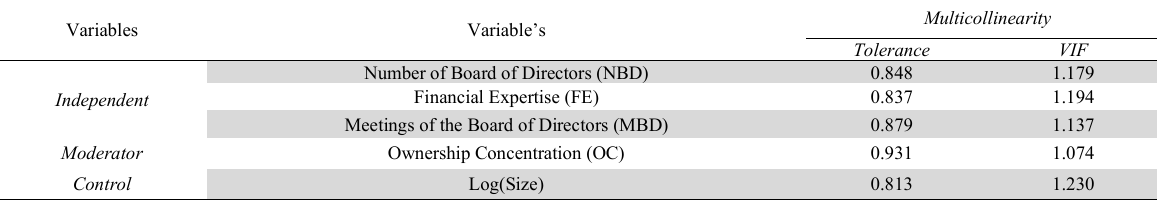
The validity of the study data for statistical analysis